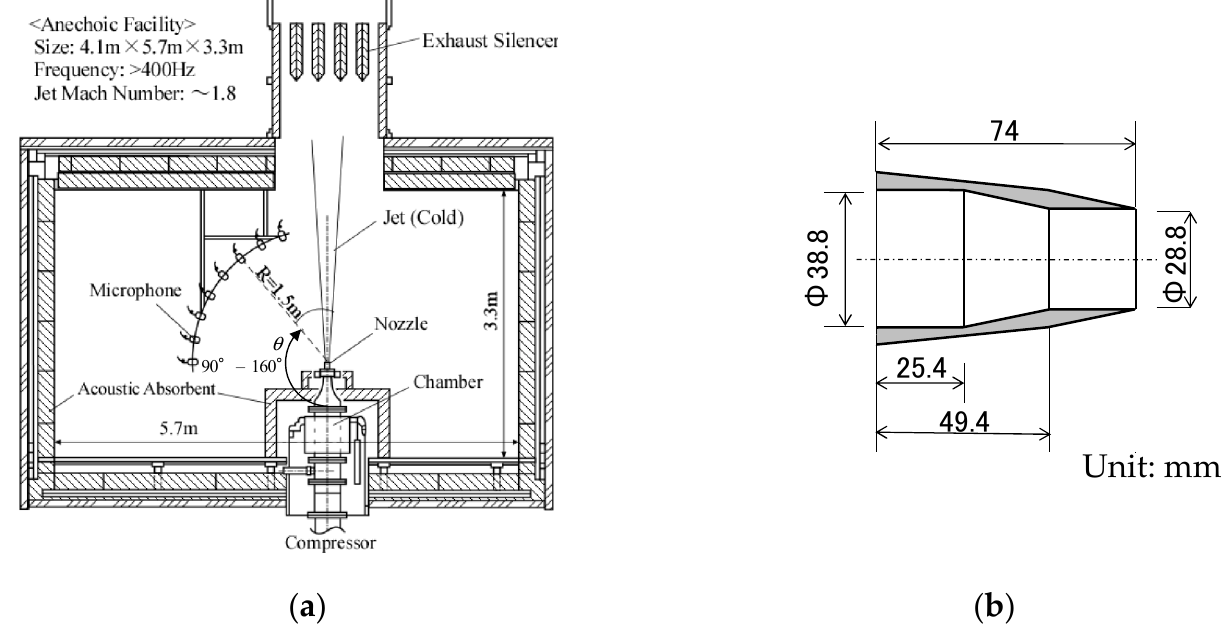
Figure 4. Experimental setup of the scale model tests for a single heat-simulated jet: ( a ) schematic diagram of JAXA’s jet noise test facility; ( b ) schematic diagram of the test nozzle.